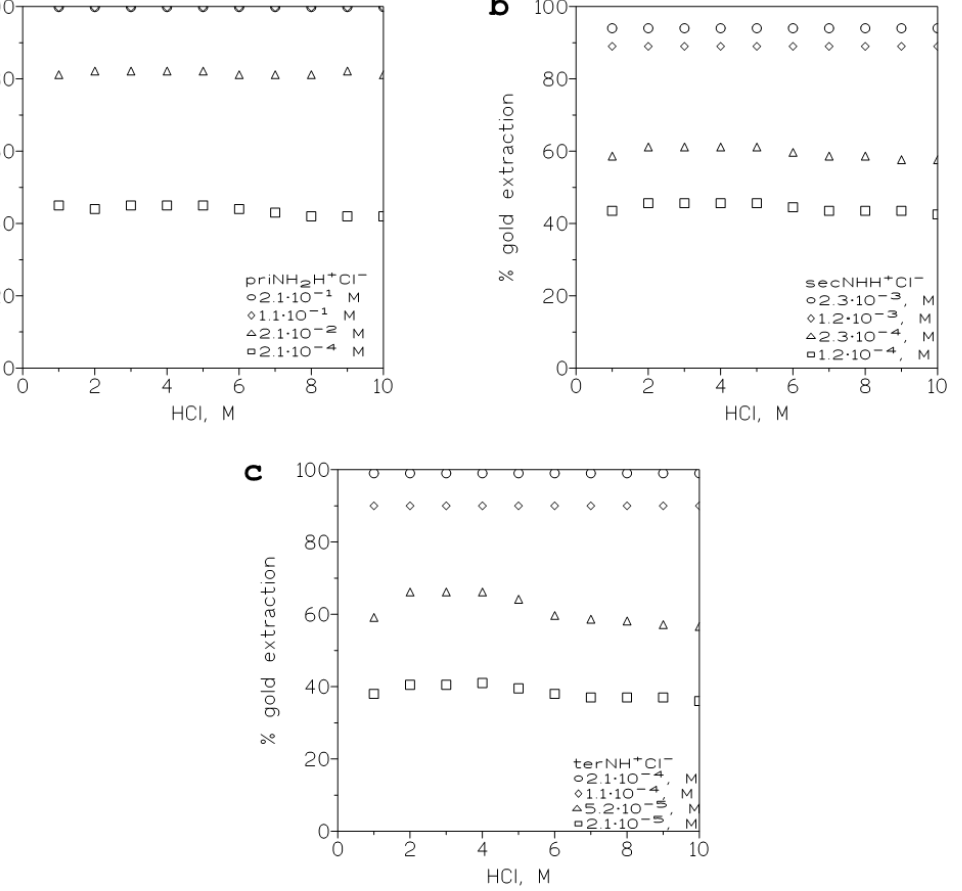
Figure 1. Variation of the percentage of gold(III) versus the HCl concentration in the aqueous phase at various PPILs concentrations in toluene. ( a ): priNH 2 H + Cl − . ( b ): secNHH + Cl − . ( c ): terNH + Cl. Equilibration time: 5 min. Temperature: 20 °C. Table 3. Values of K ext at various HCl concentrations.